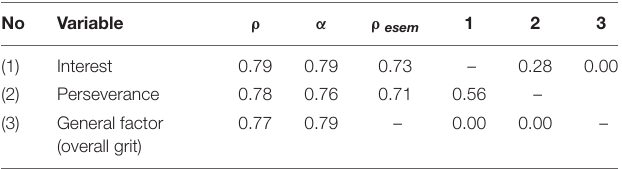
TABLE 5 | Factor correlations and internal consistencies of the factors for both the B-ICM-CFA (Model 6) and ESEM Solution (Model 8). No